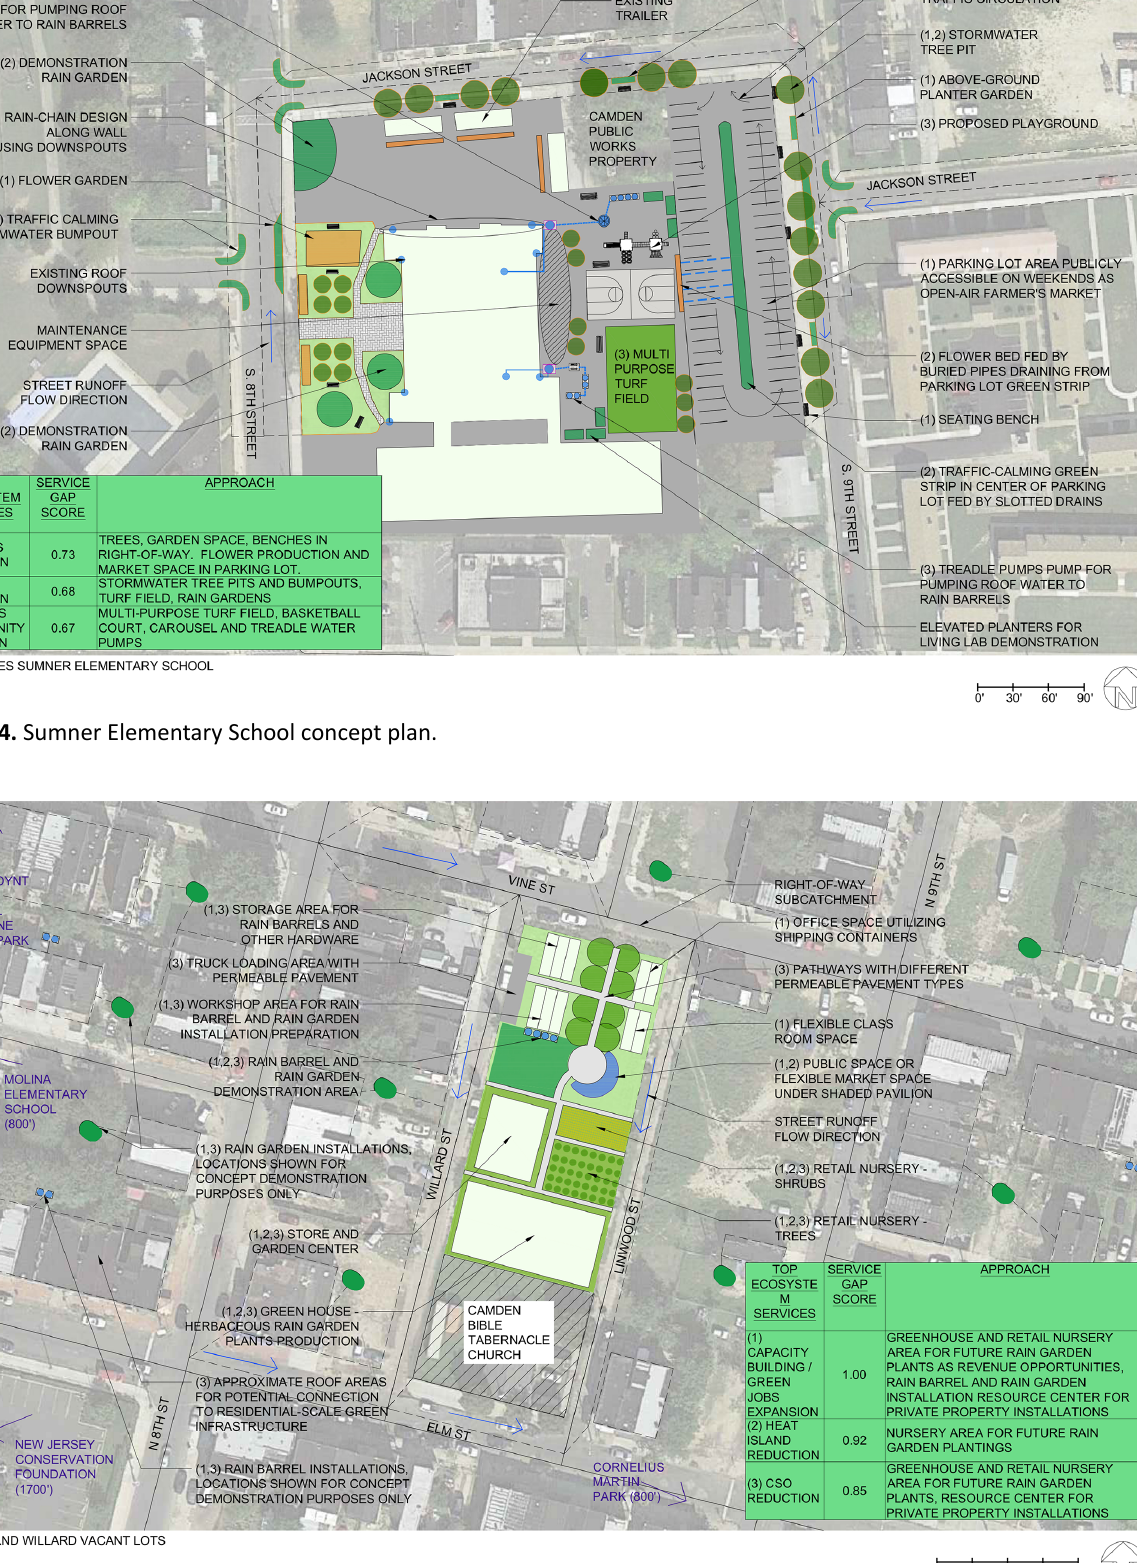
Figure 5. Vine and Willard vacant lots concept